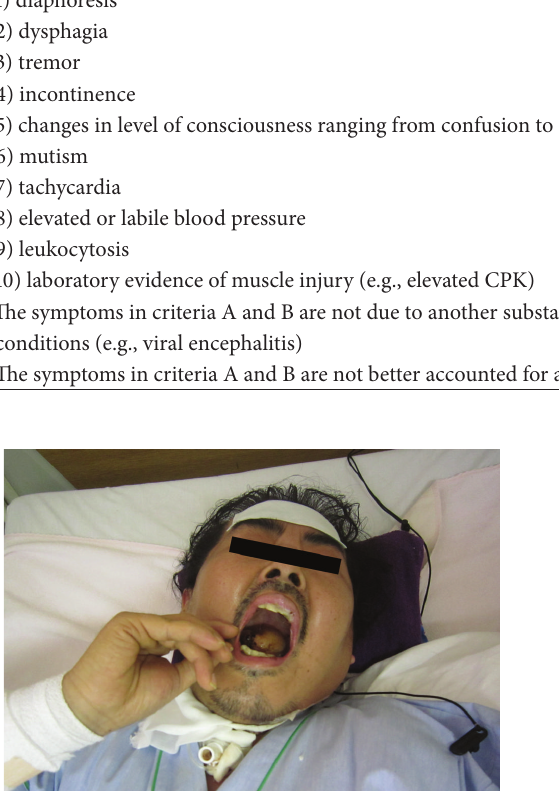
Figure 2: Case patient exhibiting NMS symptoms. Hyperthermia, significant extrapyramidal symptoms, various autonomic symp- toms, and impaired consciousness were